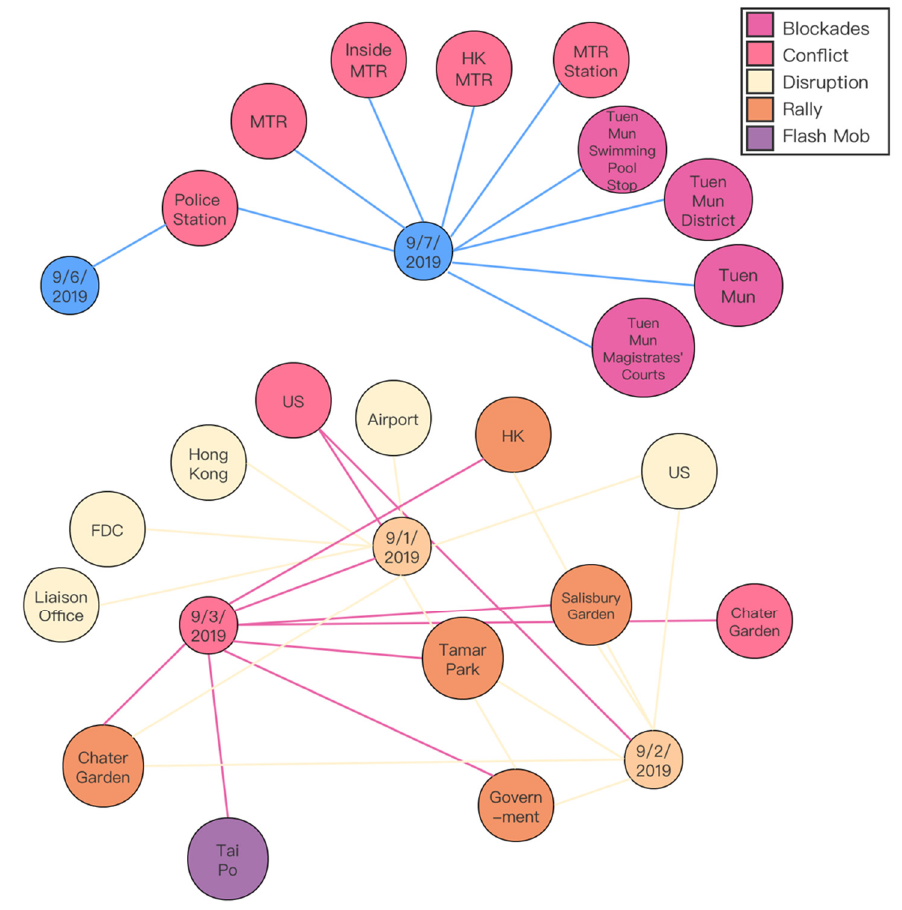
Figure 7. Entity network graph discovered in Lihkg dataset from 1 September 2019 to 7 September 2019.